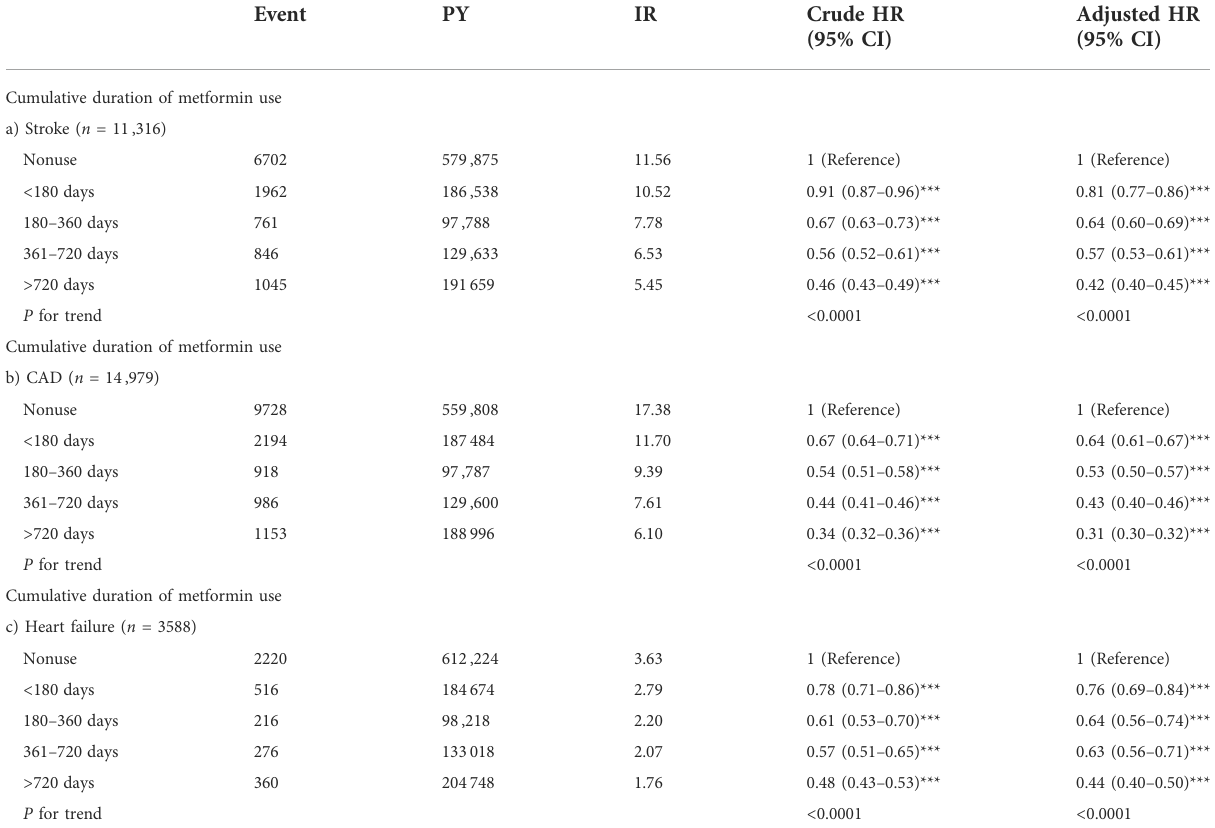
TABLE 3 Hazard ratios of cardiovascular outcomes associated with the cumulative duration of metformin